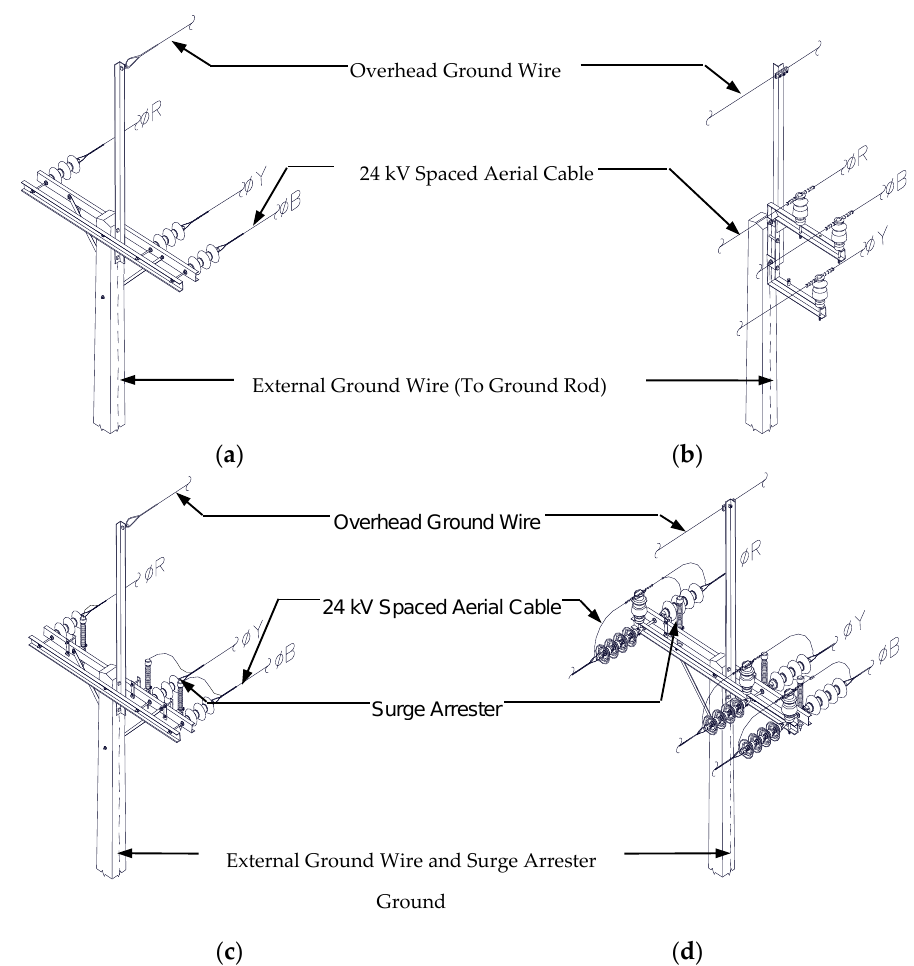
Figure 1. Distribution line system arrangement used for analysis; ( a ) Single dead-end structure (end of the line); ( b ) Angle support structure (middle of the line); ( c ) Single dead-end structure with arrester (end of the line); ( d ) Double dead-end structure with arrester (middle of the line).